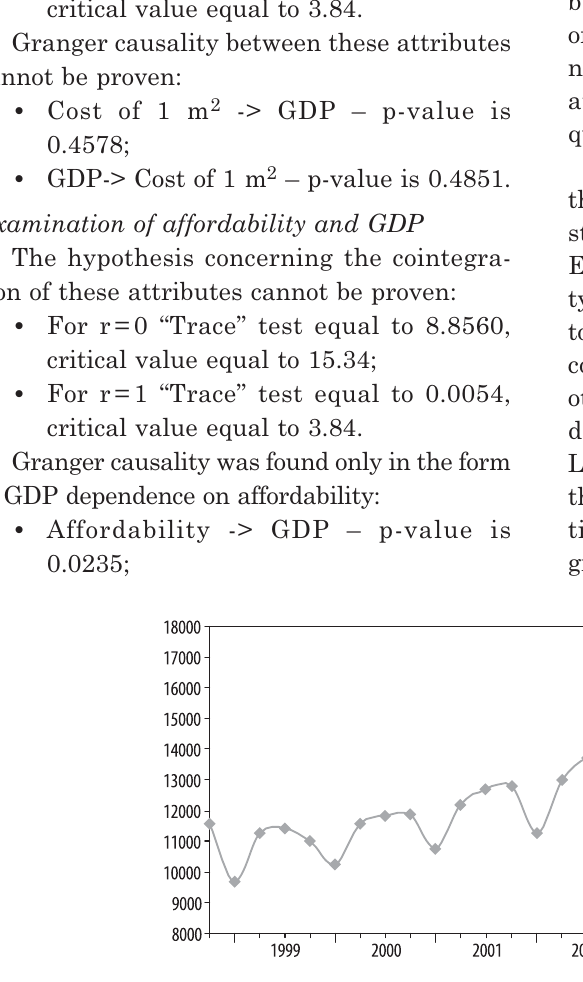
Figure 2. Variation of cost-infl uenced gross domestic product, 1998 Q4 – 2004